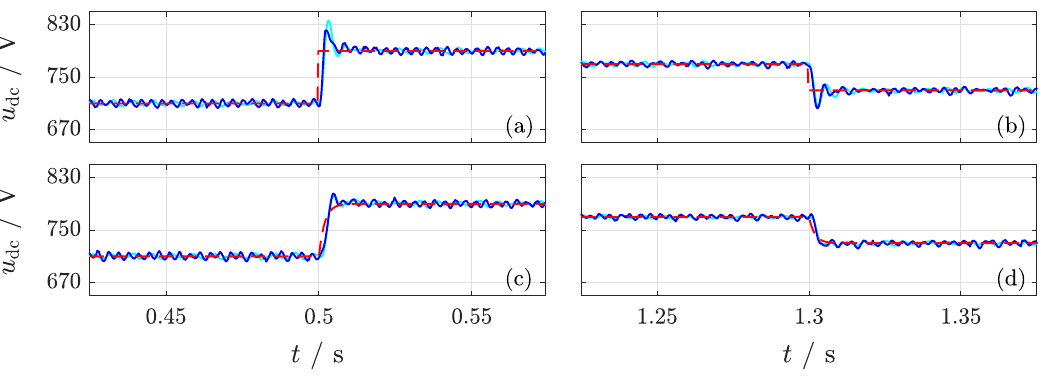
Figure 9. Experiment (E2)—Simulation and measurement results: Comparison of the reference tracking performance of the dc-link control loop without prefilter ( a , b ) and with prefilter ( c , d ). [Color code: reference signal of measurement results, simulated actual value, measured actual